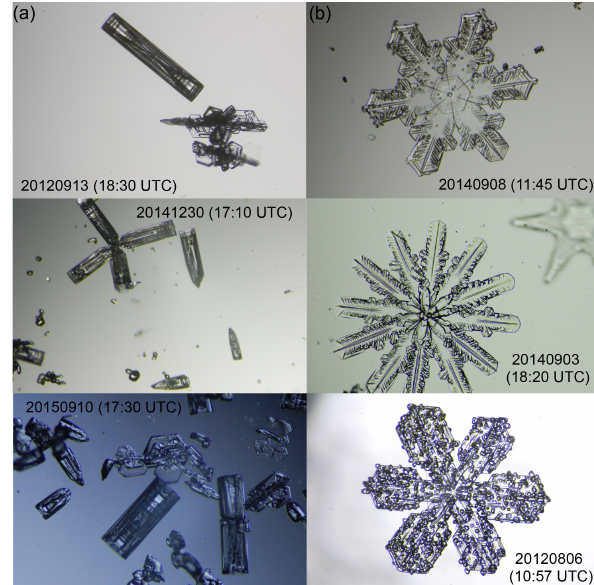
Figure 8. Examples images from the IcePIC camera of ice cloud (IC) originating snow events (a) and for mixed-phase CLW contain- ing snow events (b) . The scientific staff can only gather ice crystals during good weather; therefore this dataset is biased to precipitation events occurring during lower wind